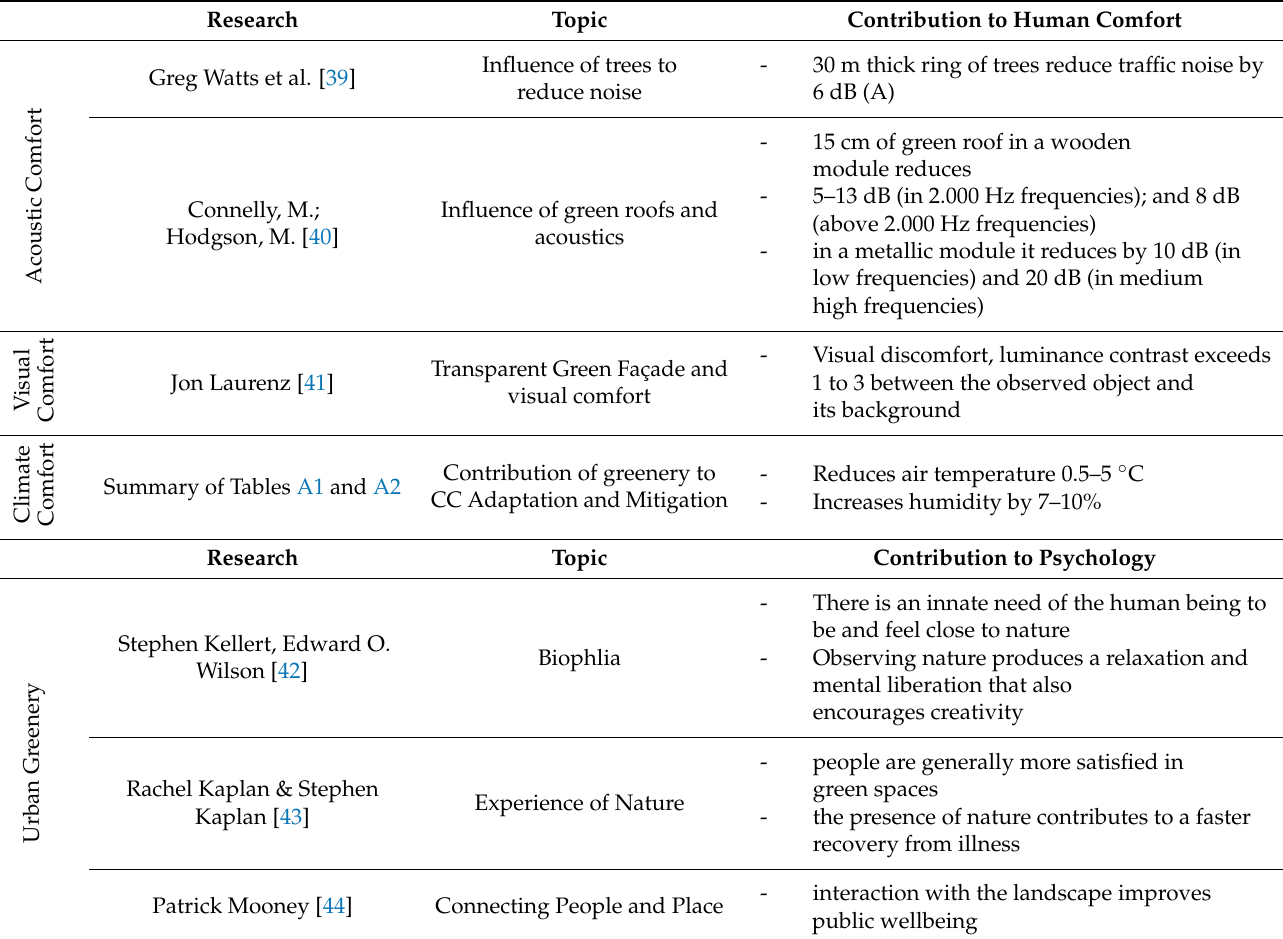
Table A3. Summary table of the contribution to human comfort and psychology (developed by the authors). Research Topic Contribution to Human Comfort Influence of trees to